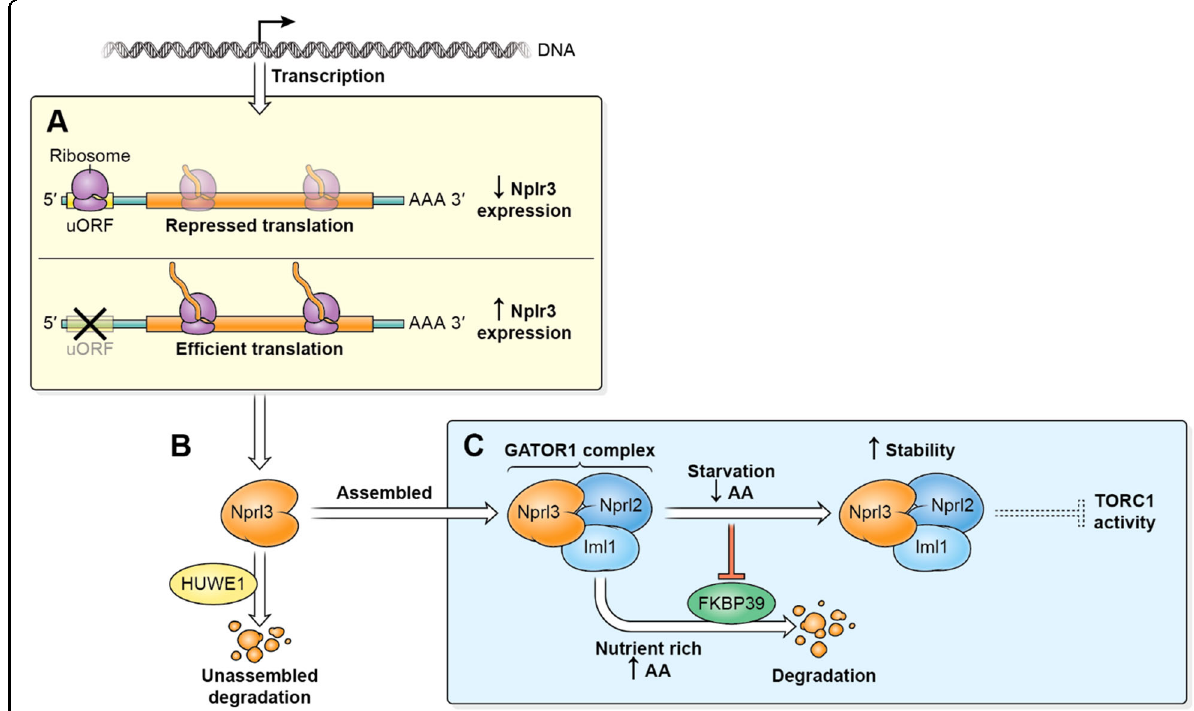
Fig. 8 Multiple pathways regulate the levels of the TORC1 inhibitor Nprl3. A The nprl3 mRNA contains a functional uORF that reduces Nprl3 translation. B Nprl3 forms the trimeric GATOR1 complex with the proteins Nprl2 and Iml1. When not assembled into the GATOR1 complex, Nprl3 is degraded via a HUWEI dependent pathway. C In nutrient-replete conditions, FKBP39 associates with Nprl3 and promotes its degradation. Upon amino acid starvation, the FKBP39 dependent destruction of Nprl3 is blocked, and the increased levels of GATOR1 resulting in decreased TORC1